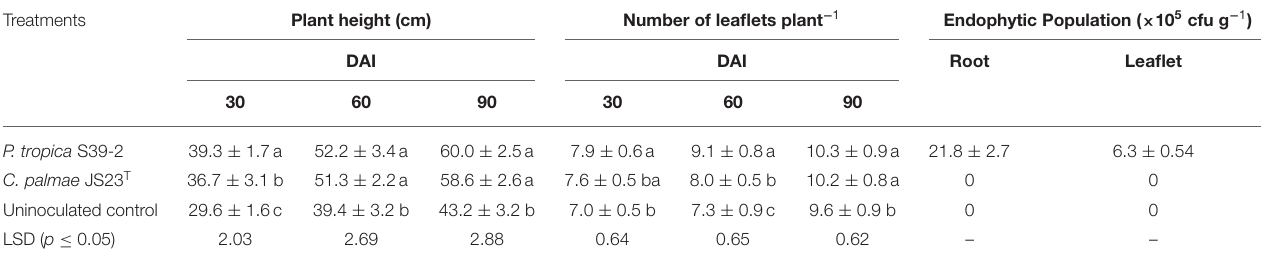
TABLE 3 | Effect of bacterial inoculation on the growth of oil palm seedlings. Treatments